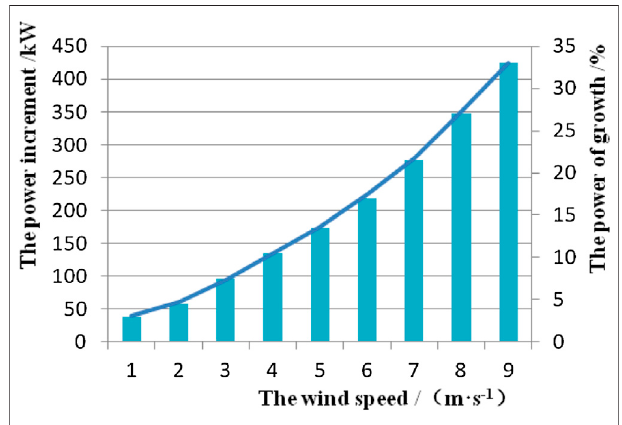
FIGURE 3 | Diagram of growth of output power correspond to 1 m/s increase in wind speed.